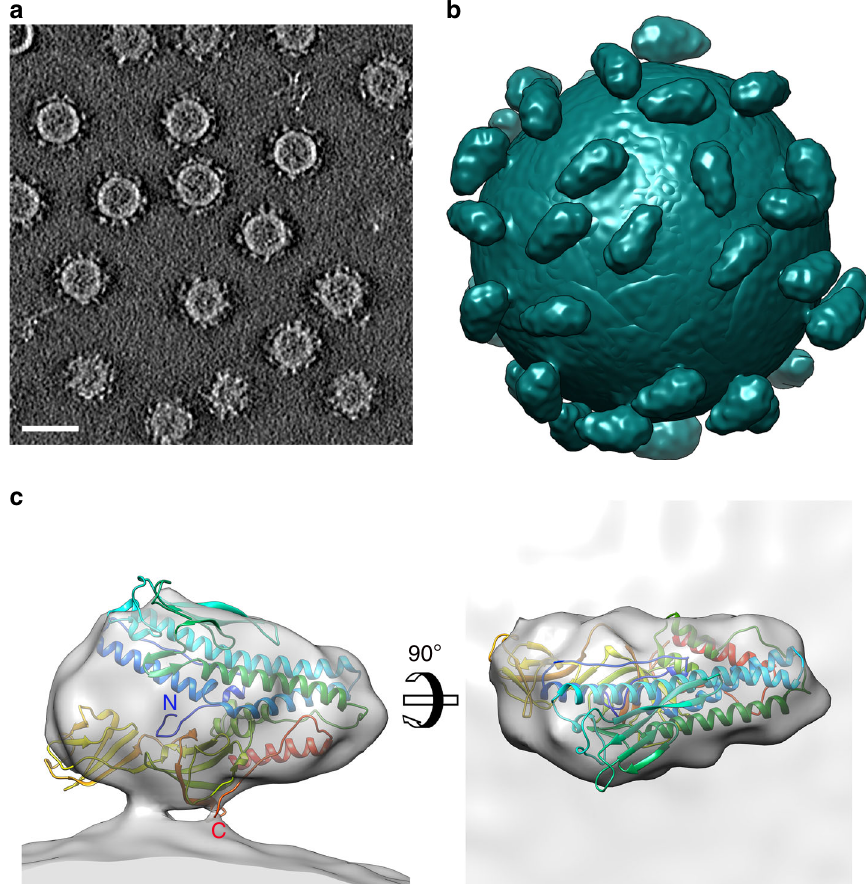
Fig. 2 Cryo-electron tomography studies of HRPV-6. a A slice through a 3D tomogram of HRPV ‐ 6 reconstructed from tilt series data collected using a Volta phase plate. The scale bar corresponds to 40 nm. b Reconstruction of an HRPV-6 virion. 41 VP5 spikes were found from a representative HRPV-6 virion by manual picking. The EM density was projected onto the aligned positions and orientations of these spikes. c VP5 crystallographic structure fi tted into its density solved by cryo-electron tomography and subtomogram